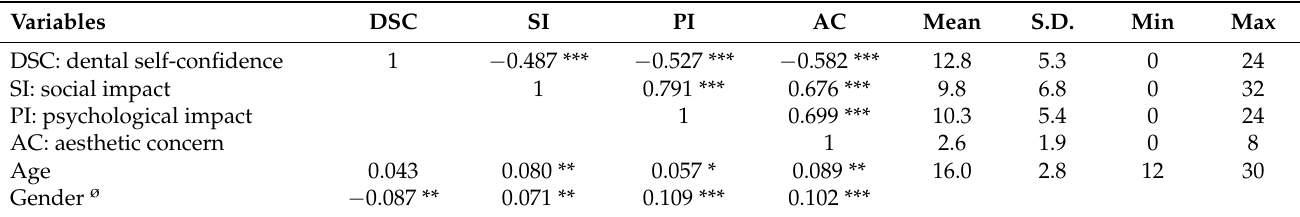
Table 2. Correlations between the variables of interest and their descriptive statistics.